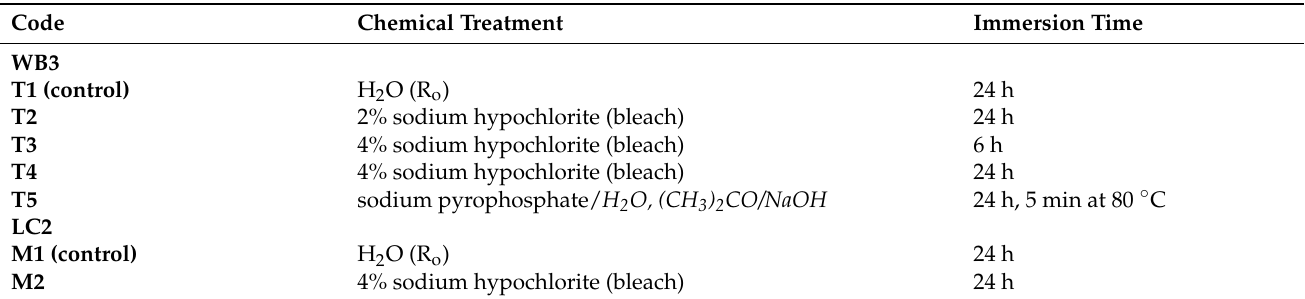
Table 1. Treatment methods tested on WB3 and Lc2